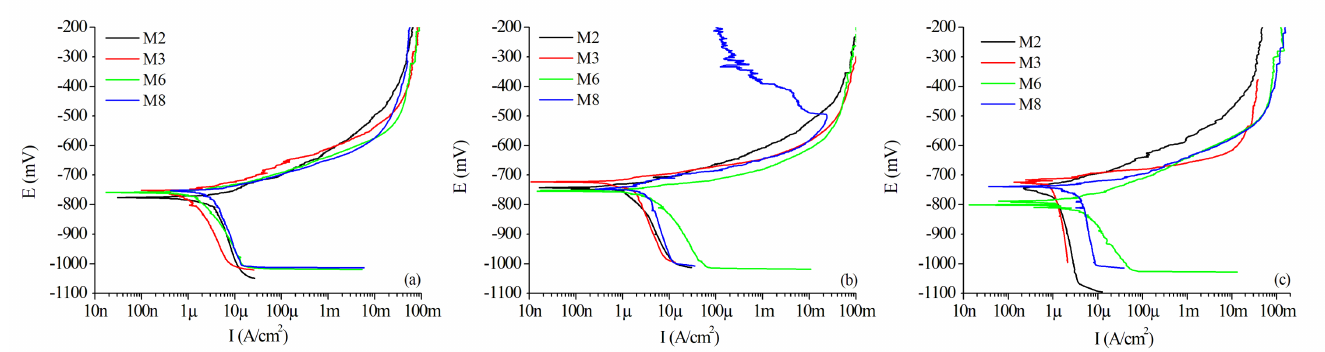
Figure 12. Evans diagrams for selected samples in different zones: ( a ) Base Metal, ( b ) Weld Zone, and ( c ) Heat-Affected